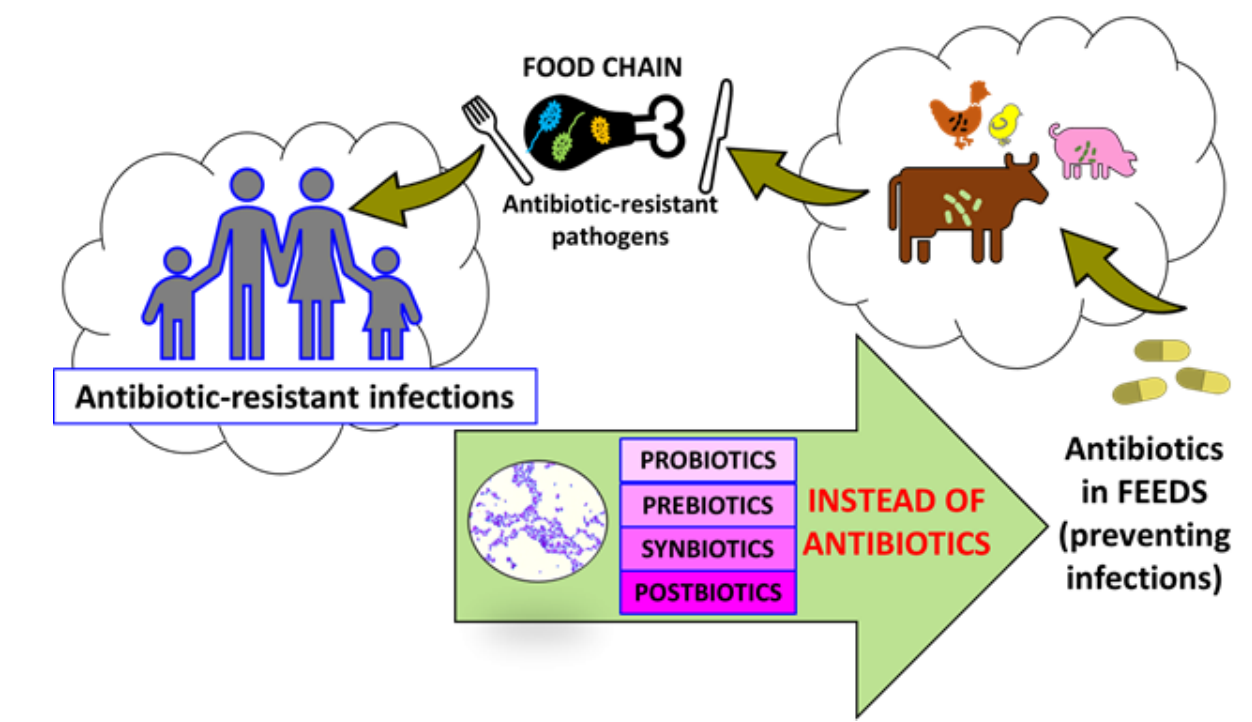
Figure 1. Effect of antibiotics application in animal